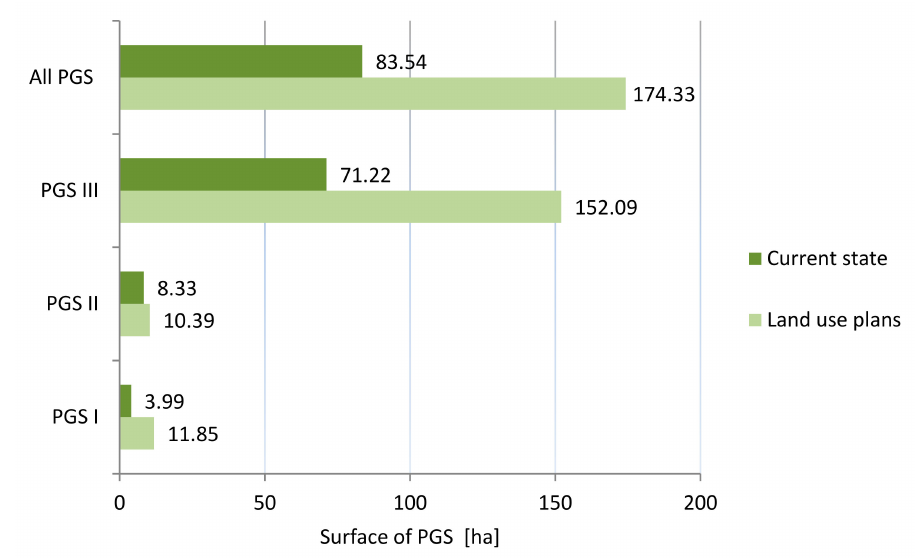
Figure 11. Changes in the surface area of PGS: current state and land use